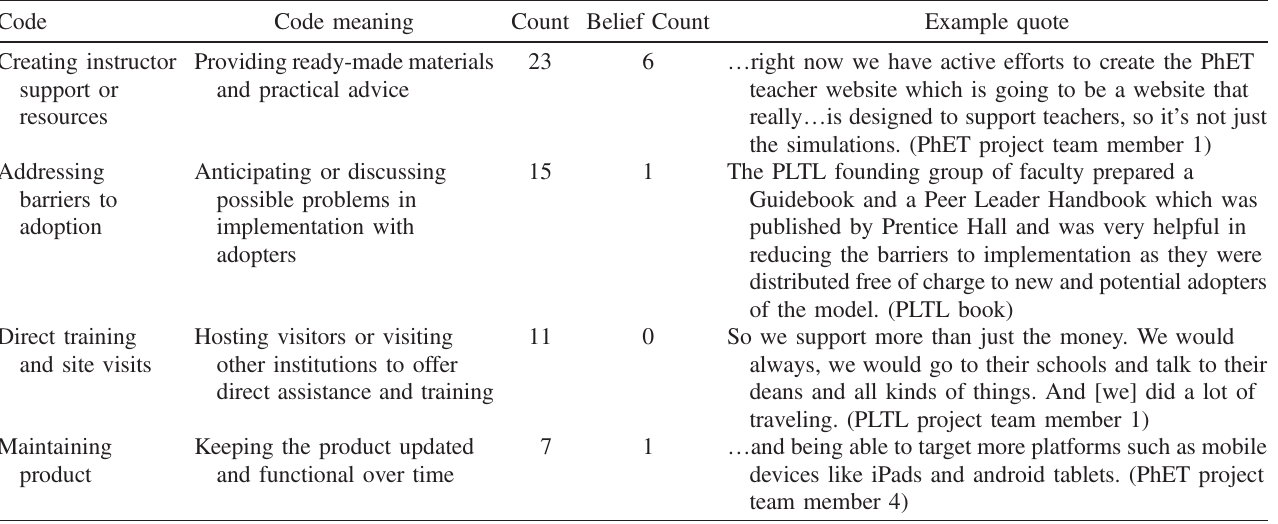
TABLE VIII. Frequently used codes and example quotes for the support